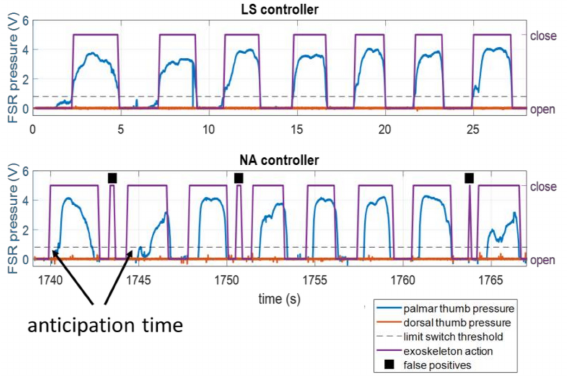
Figure 4. Example of thumb pressures detected during operation of a limit switch controller ( top ) and an EMG controller ( bottom ) along with exoskeleton action. The thumb pressure and limit switch threshold lines correspond to the left axis, and the exoskeleton action corresponds to the right axis. The bottom plot shows how exoskeleton actuation often occurs before the limit switch threshold is reached with the EMG controller, as the black line changes before the red line hits the dashed limit. False positive predictions are marked with black